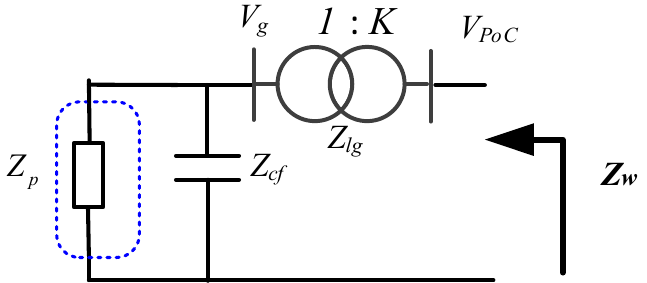
Figure 5. Simplified wind turbine (WT) system model, Z p = equivalent small-signal positive impedance, Z cf = filter capacitor impedance, Z lg = leakage impedance.